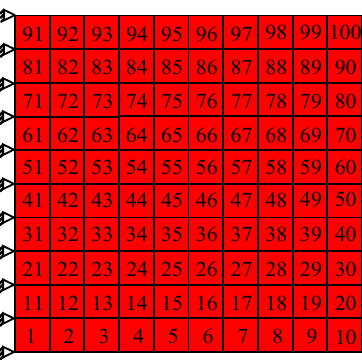
Figure 6. The finite element model of hard ‐ coating thin plate. Table 2. The obtained modal loss factor of hard ‐ coating thin plate/10 − 3 .